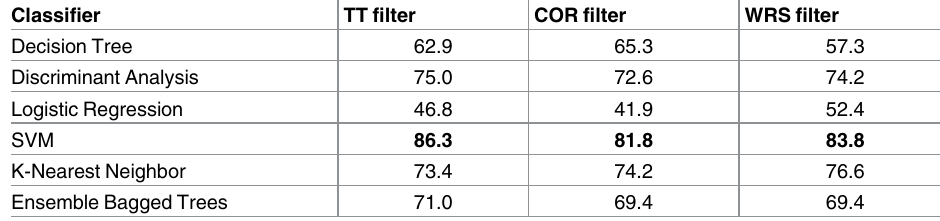
Table 3. Accuracy percentages of six different classifiersused after the first selection stage in 10-fold